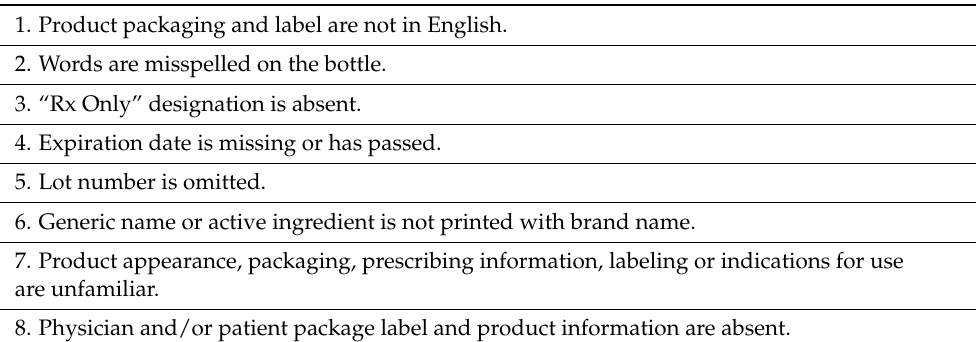
Table 3. The signs of counterfeiting [61]. Abbreviations used: Rx, Prescription.